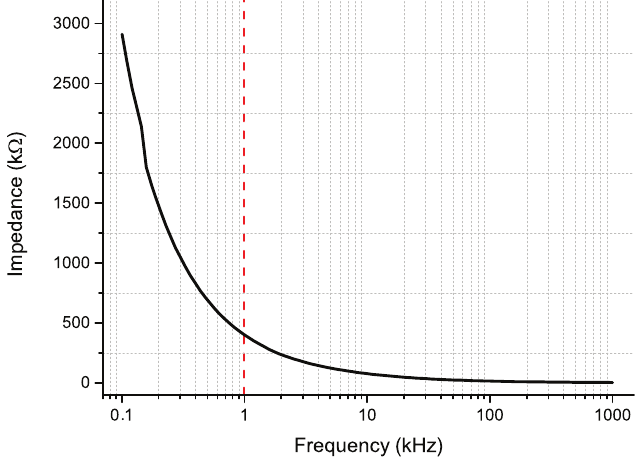
50 µ m 2 recording sites. ×